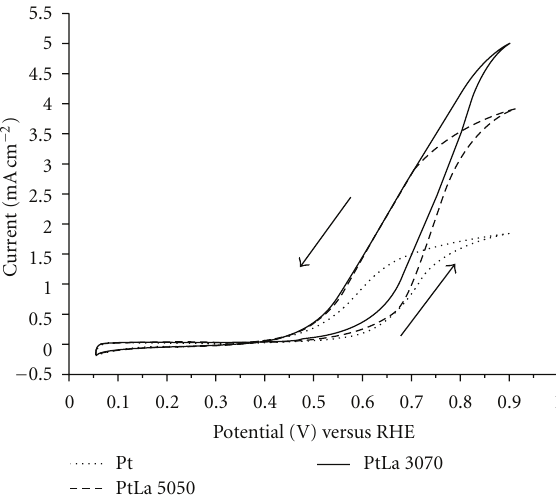
Figure 2: Current-time curves at 0.55 V in 1.0 molL − 1 CH 3 CH 2 OH + 0.5 molL − 1 H 2 SO 4 solution for Pt/C, PtLa/C (50:50) and PtLa/C (30:70)